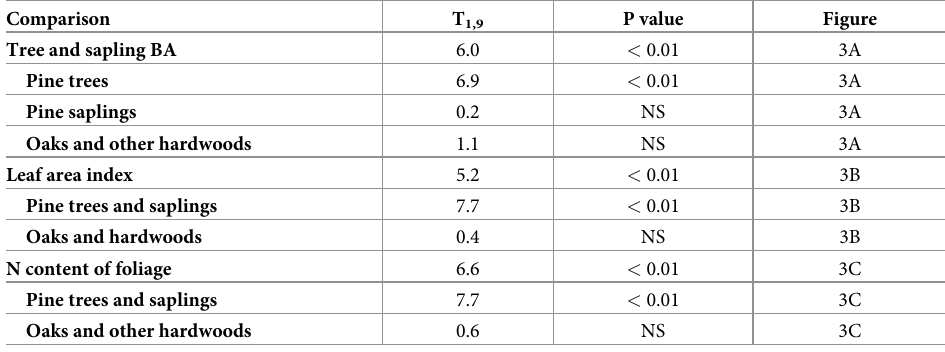
Table 2. Results of paired-sample T-tests for structural characteristics of stands infested by southern pine beetle.